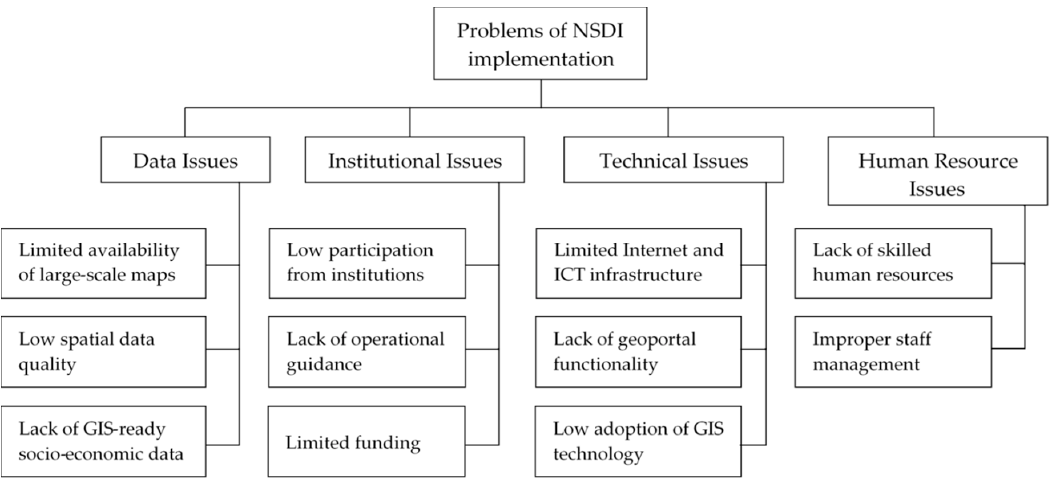
Figure 1. Problems in national spatial data (NSDI) implementation, as identified by the interviewees. Geographic information system (GIS), information communication technology (ICT).